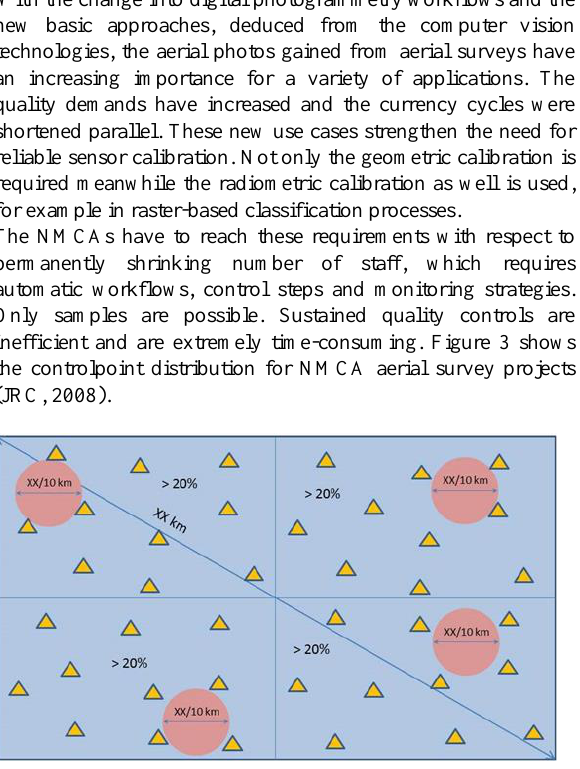
Figure 3: Controlpoint distribution for NMCA aerial